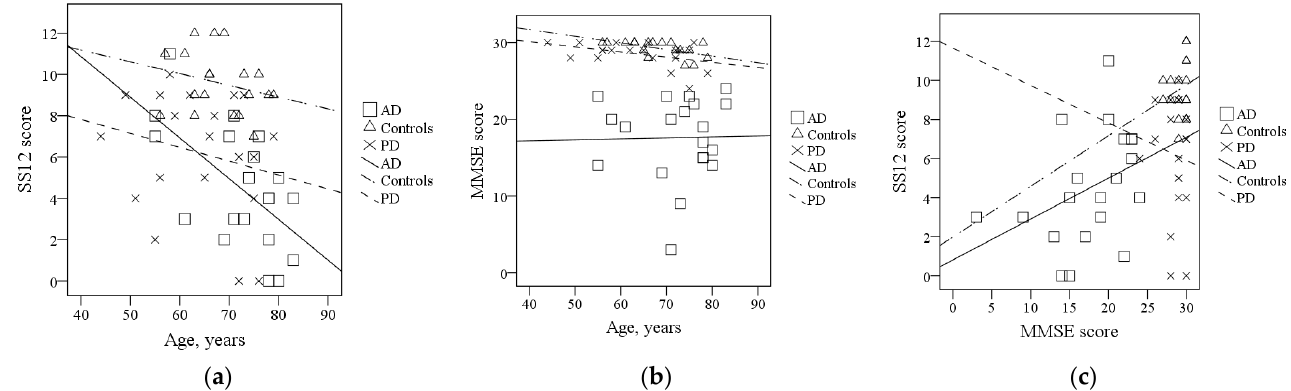
Figure 1. Correlations between SS12 scores, MMSE scores, and age: ( a ) Correlations between age and SS12 scores: AD: ρ = − 0.526, p = 0.017; PD: ρ = − 0.217, p = 0.359; Controls: r = – 0.257, p = 0.288; ( b ) correlations between age and MMSE scores: AD: ρ = 0.086, p = 0.718; PD: ρ = − 0.304, p = 0.193; Controls: ρ = − 0.598, p = 0.007; ( c ) correlations between MMSE and SS12 scores: AD: ρ = 0.443, p = 0.050; PD: ρ = − 0.114, p = 0.633; Controls: ρ = 0.203, p = 0.406. Abbreviations : AD, Alzheimer’s disease; PD, Parkinson’s disease; SS12, Sniffin’ Sticks 12 test; MMSE, Mini Mental State Examination.